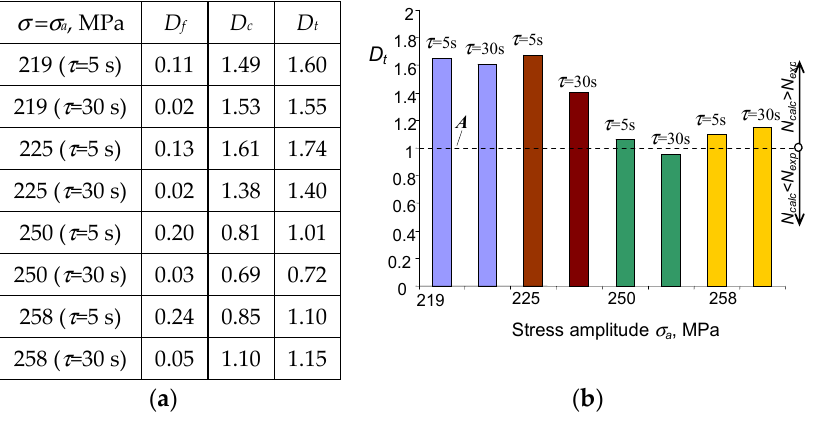
Figure 14. ( a ) Damage levels resulting from calculations; ( b ) interpretation of results.